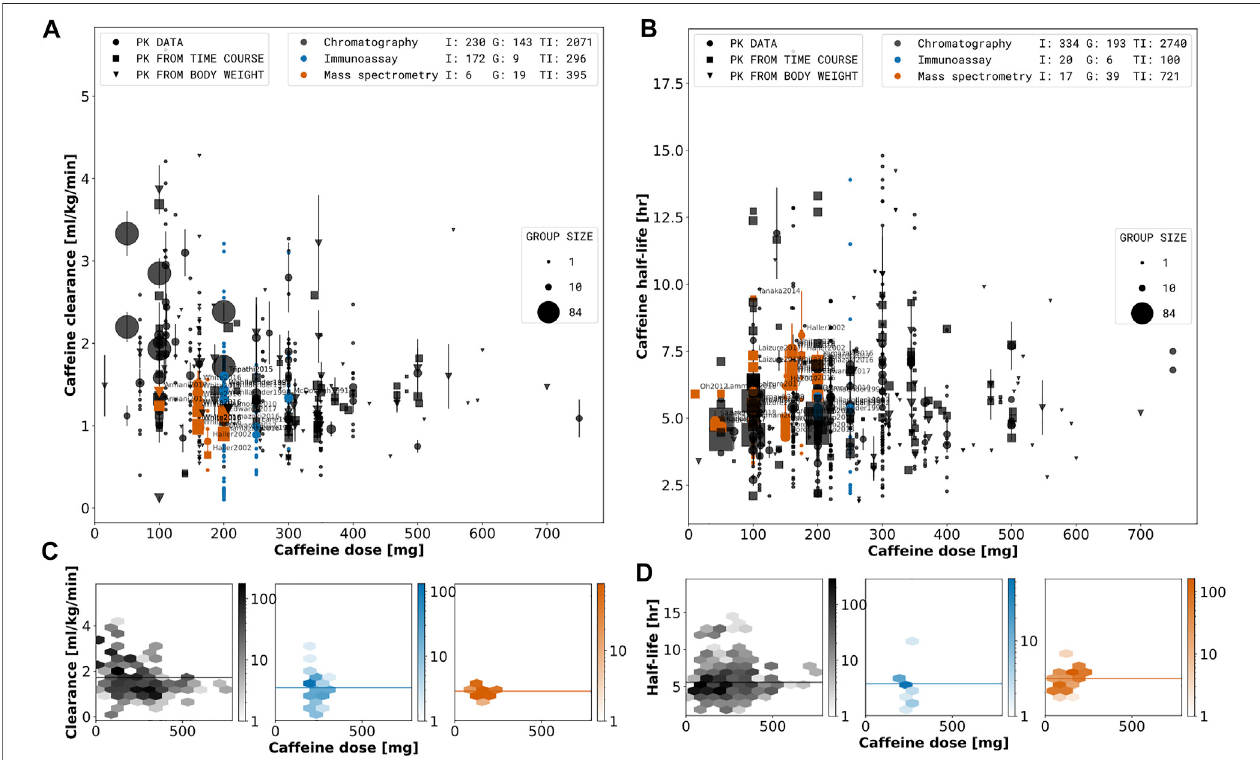
FIGURE4| Effectoftypeofassayonpharmacokineticparameters.Astrati fi edmeta-analysisofcaffeineclearance (A) andhalf-life (B) dependingonreportedassay type and dose. Orange: Measurements performed with mass spectrometry (LC MS, LC MS/MS, HPLC MS/MS, HPLC-ESI-MS/MS, ES MS/MS). Blue: Measurements performed with immunoassay (RIA, EMIT). Black: Separation performed with chromatographybut quanti fi cation assay was not reported (HPLC, RP-HPLC, GLC, CGC, CC, GC). Marker shape, and size describe the datatype and group size, respectively. Data with reported quanti fi cation method are labeled by the respective study name. The hexagonal bin plots in the lower panel (C, D) correspond to the subset of data for the mass spectrometry quanti fi cation, immunoassay quanti fi cation and chromatography. The color intensity of each bin represents the number of subjects falling in a given hexagonal bin area. Data selection criteria and visualization are described in the Section 2